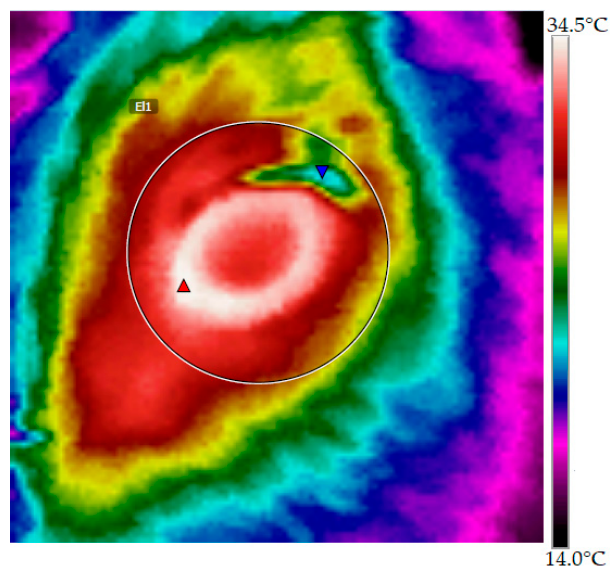
Figure 1. Infrared image of the eye region of a calf. Red triangle indicates maximum eye temperature (MET).